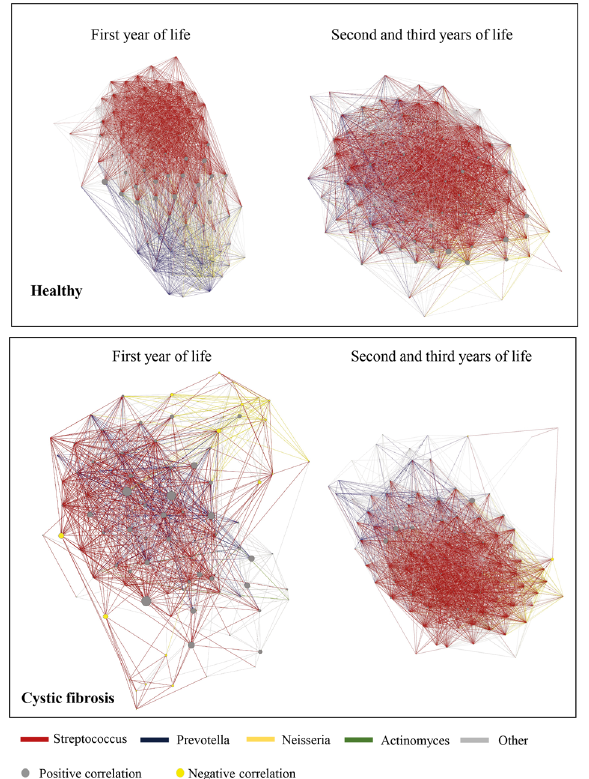
Fig. 5 Ecological network analysis of species Spearman ’ s correla- tion matrices in healthy and diseased infants. The ForceAtlas algorithm was applied to Spearman ’ s rank correlation matrices, which were calculated from absolute species abundance tables of shotgun metagenomic sequencing data. Directed networks were generated by including only signi fi cant and strong positive correlations ( p < 0.05, Spearman ’ s rank correlation coef fi cient > 0.60) and all signi fi cant negative correlations ( p < 0.05), which are represented by grey and yellow nodes, respectively. Coloured edges visualise correlations that involve one of the four genera that explain most of the correlations (Streptococcus, Veillonella, Actino- myces and Neisseria), whereas all other edges are shown in grey. The size of network nodes refers to the corresponding betweenness centrality.